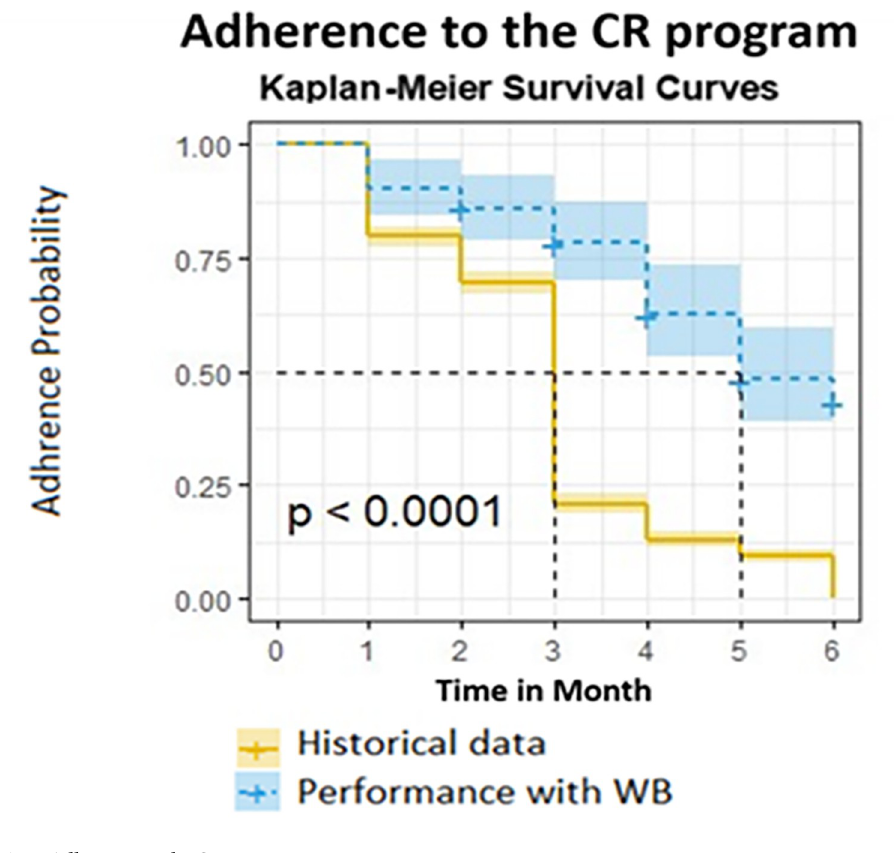
Fig 2. Adherence to the CR